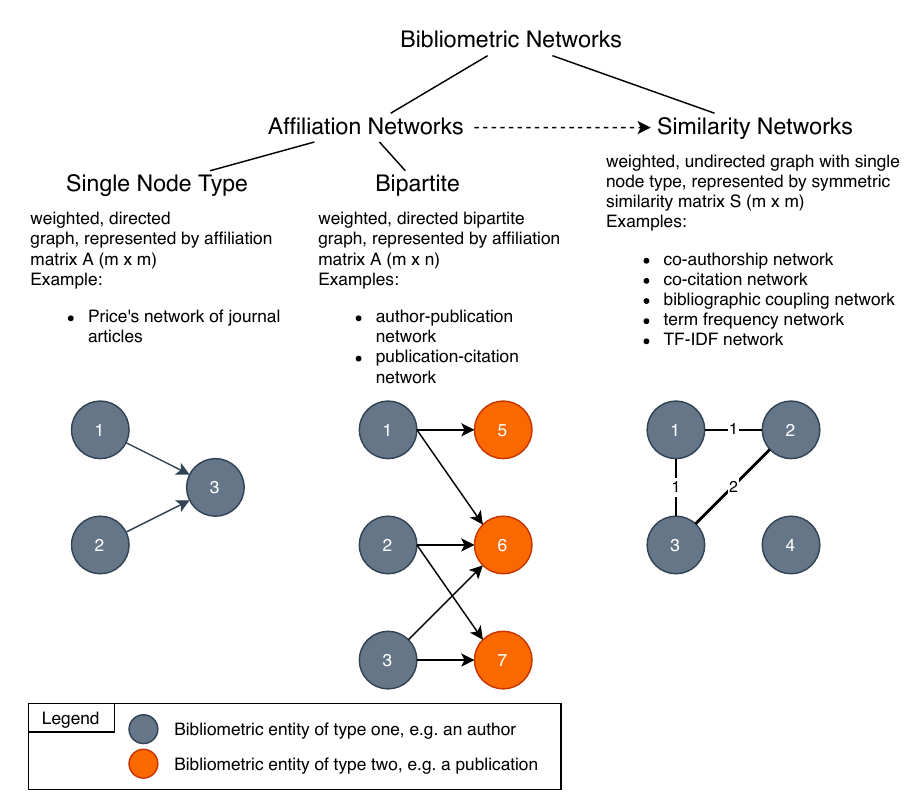
Figure 2. Bibliometric networks—overview. Affiliation networks are represented by a weighted, directed graph whose nodes represent bibliographic entities of any type. Most common are bipartite affiliation networks, which depict a bipartite graph, i.e., there are only two types of nodes in the graph, and nodes of the same type must not be directly connected. A bipartite graph can be represented by a matrix A of size m × n , with m denoting the number of nodes of type one and n denoting the number of nodes of type two. The entry a ij of A yields the value of the affiliation from the i th node of type one to the j th node of type